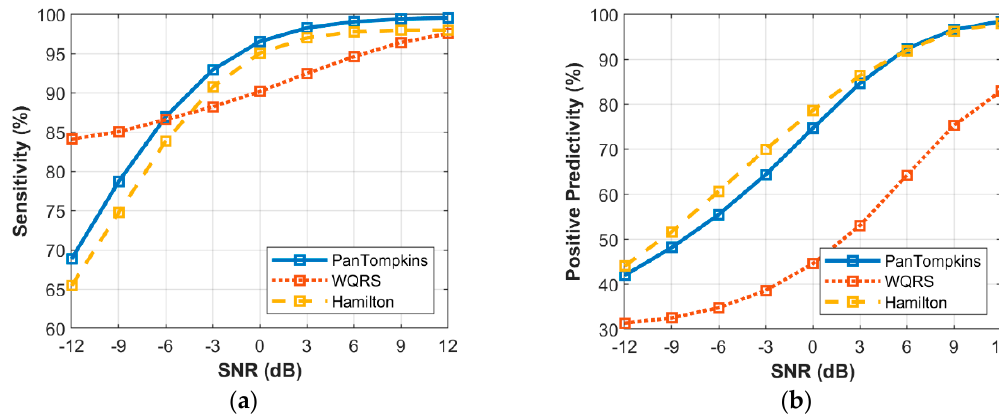
Figure 14. Relationship between the performance of beat detection and EM artefact for all the 48 records: ( a ) sensitivity with SNR; ( b ) positive predictivity with SNR.